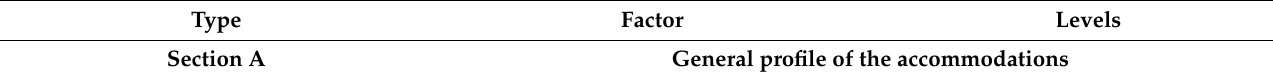
Table A1. Variables collected in the survey to describe the supply of rural lodging and to identify the relationships with the agricultural